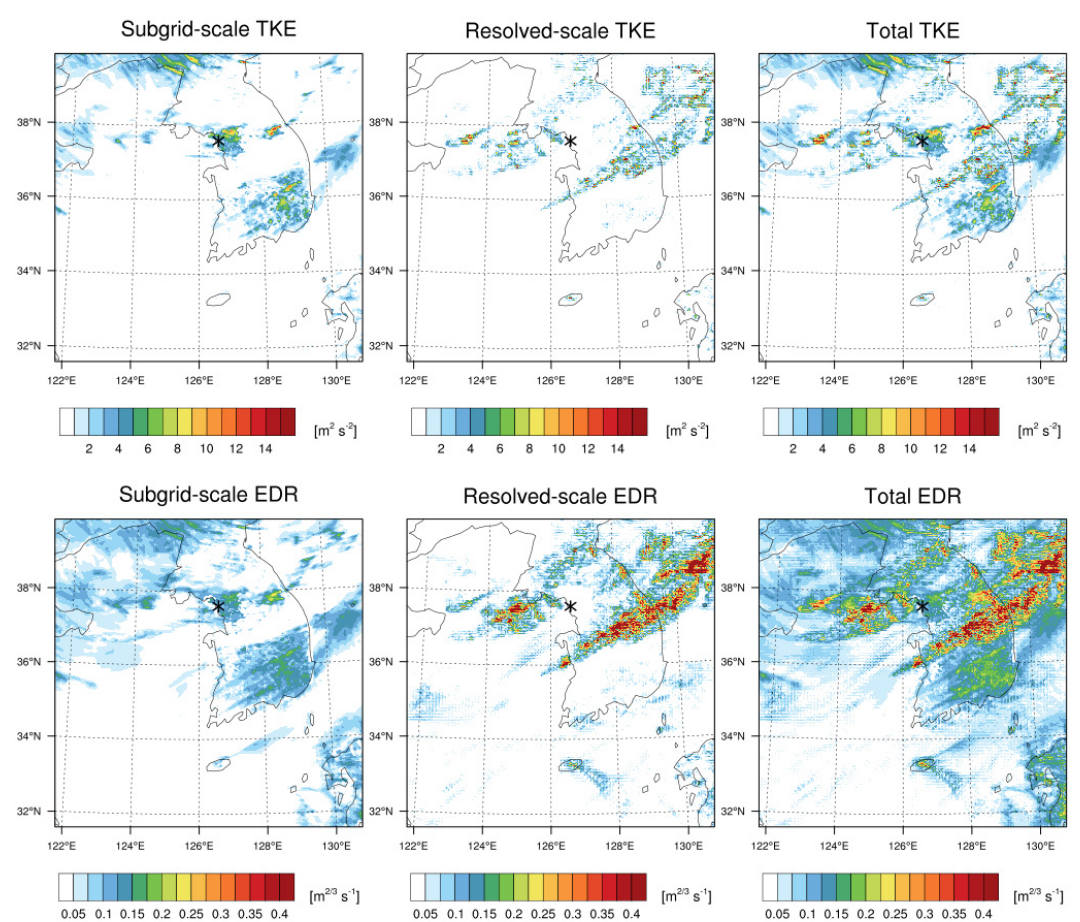
Figure 13. Horizontal distributions of (upper panels) turbulent kinetic energy (TKE) and (lower panels) EDRs converted from (left) sub-grid scale (SGS), (middle) resolved, and (right) total TKEs at 06:40 UTC on 28 October 2018 at the altitude of 2.2 km. The asterisk indicates the location of the CIT event.